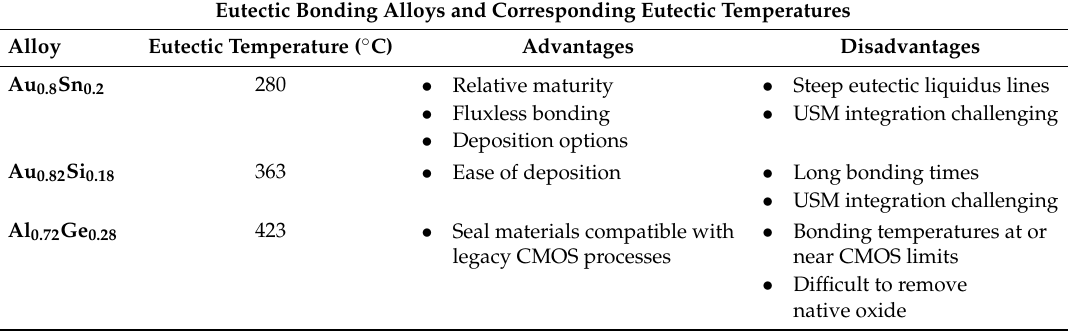
Table 3. List of the most commonly used and applicable eutectic